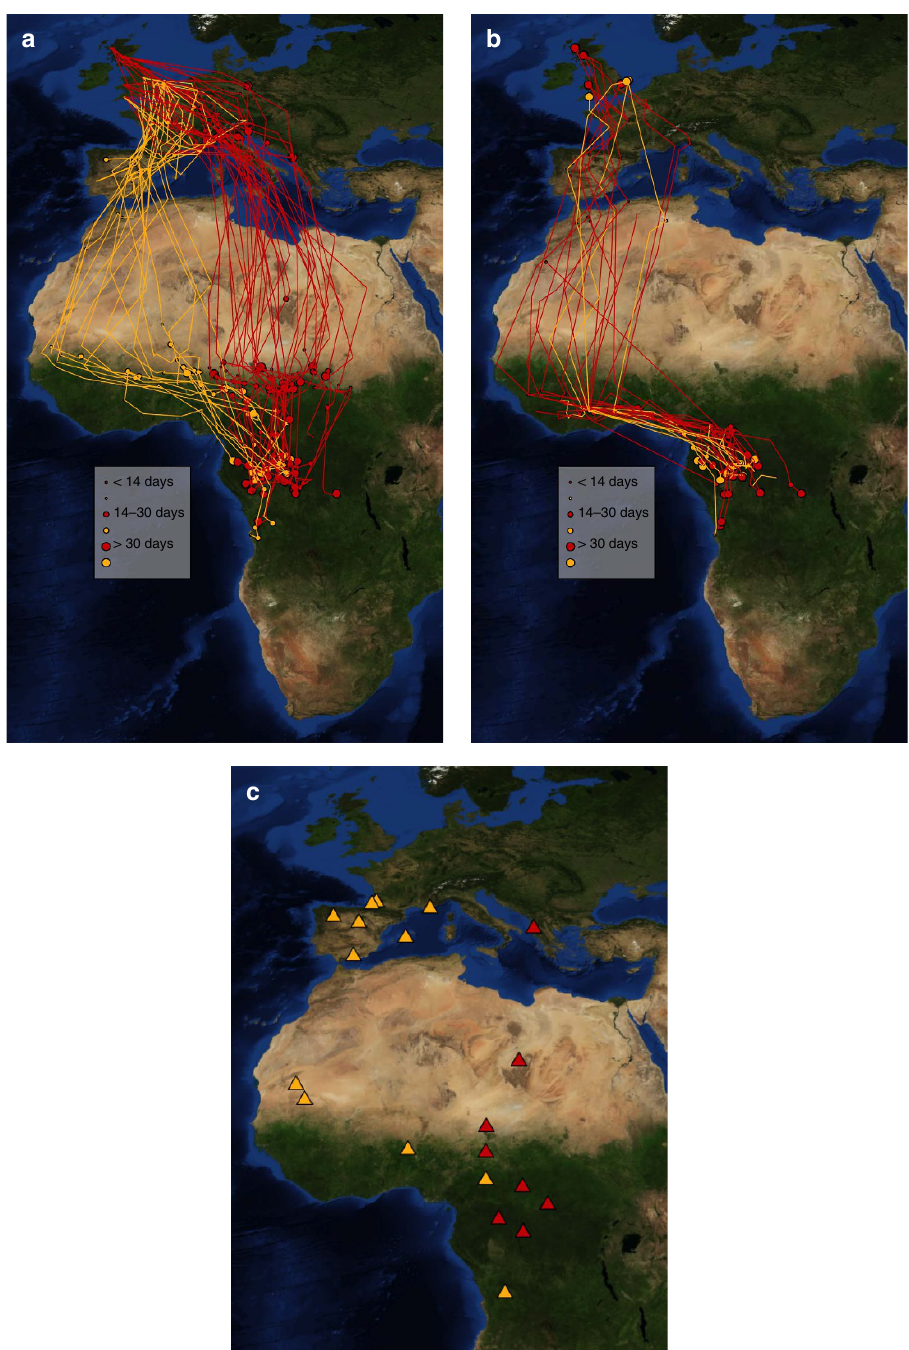
Figure 2 | Migration routes and apparent mortality locations of tagged cuckoos. ( a ) Autumn (southwards) and ( b ) spring (northwards) migration routes and stopover locations, and ( c ) apparent mortality locations during autumn migration of cuckoos using the East (red) and West (yellow) routes. In a , b , circle size indicates stopover duration as shown in the key. There was no difference in the final (mid-winter) locations of birds using the two routes (binomial GLMM; latitude: df 1, 7, F ¼ 1.09, P ¼ 0.332; longitude: df 1, 7, F ¼ 0, P ¼ 0.962; latitude*longitude: df 1, 7, F ¼ 1.3, P ¼ 0.292). Estimates of survival of birds using the two routes are given in the text. Base map OpenStreetMap